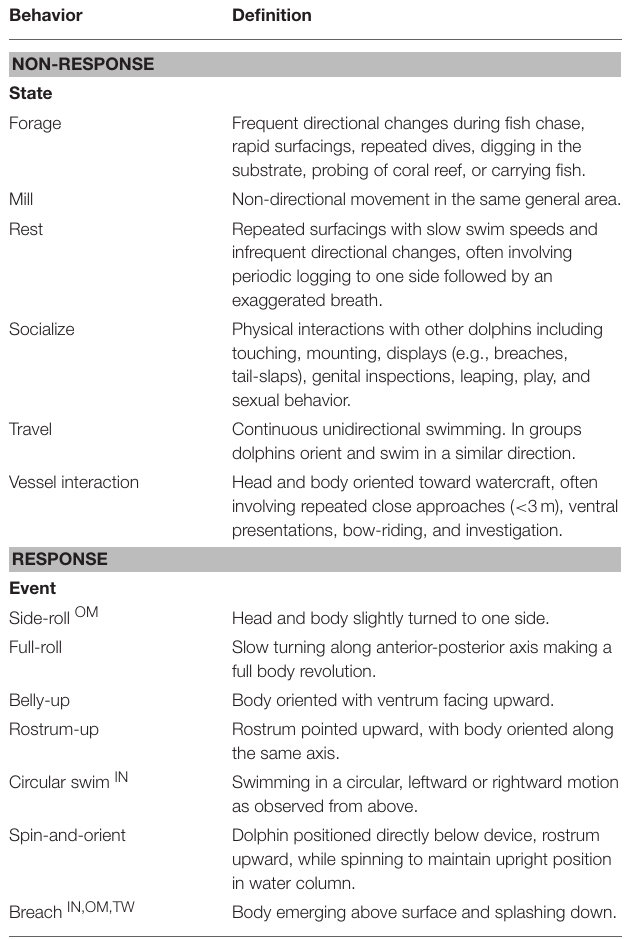
TABLE 1 | Ethogram of non-response and response behaviors of bottlenose